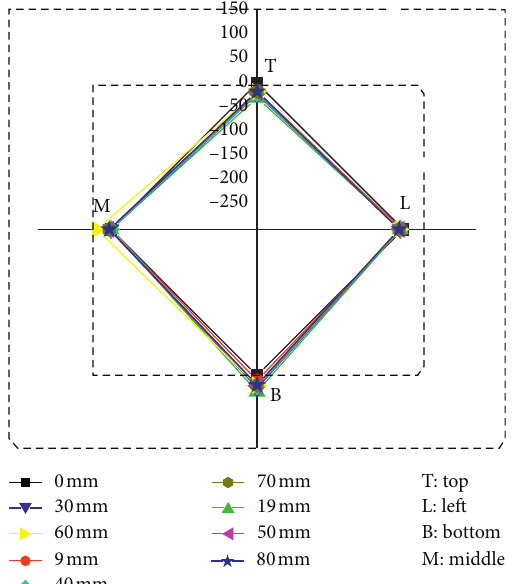
Figure 23: Footwall cross-sectional cabin 2